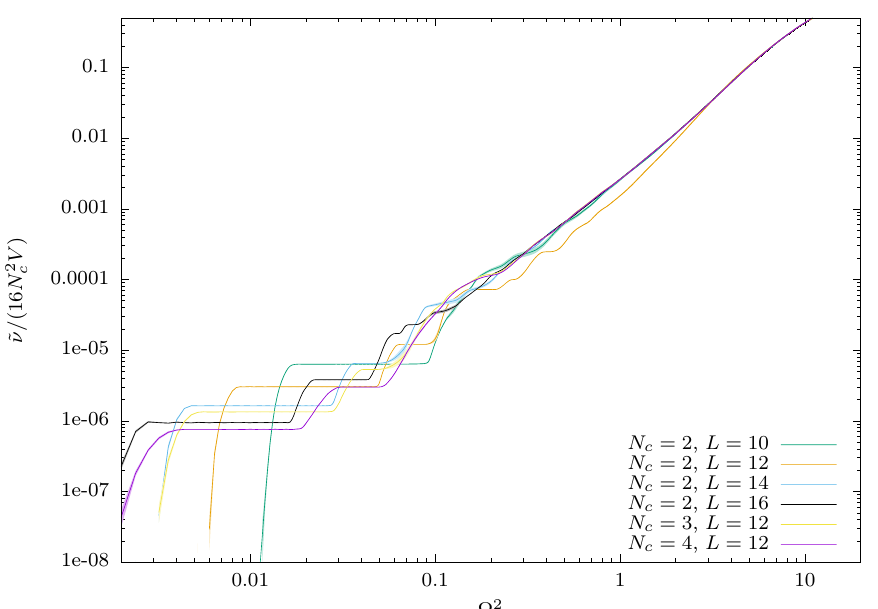
Figure 10. Normalized mode number for different volumes L 4 and gauge groups U( N c ) at a fixed lattice ’t Hooft coupling λ lat = 0 . 5